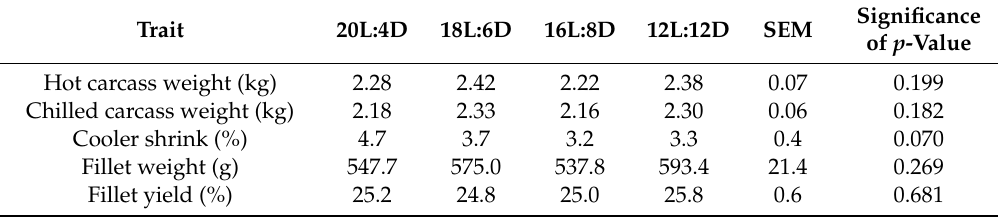
Table 1. E ff ect of photoperiod on broiler carcass characteristics ( n = 6 /